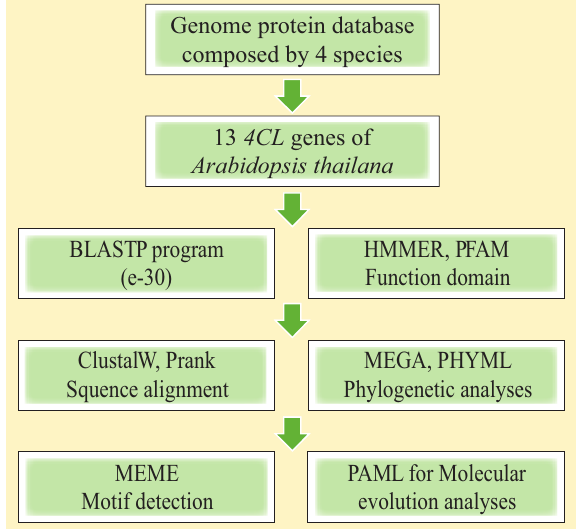
Figure 1. Schema of the